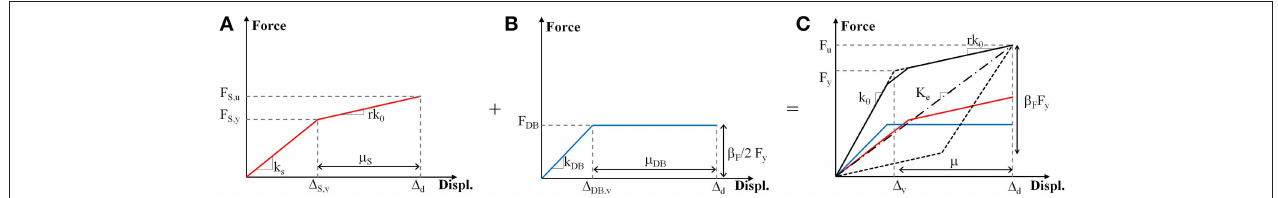
FIGURE 3 | Equivalent SDOF systems of (A) Bilinear elastic model of the bare post-tensioned frame F; (B) Hysteretic model of dissipative bracing system DB; (C) Flag-shape of braced post-tensioned frame BF.